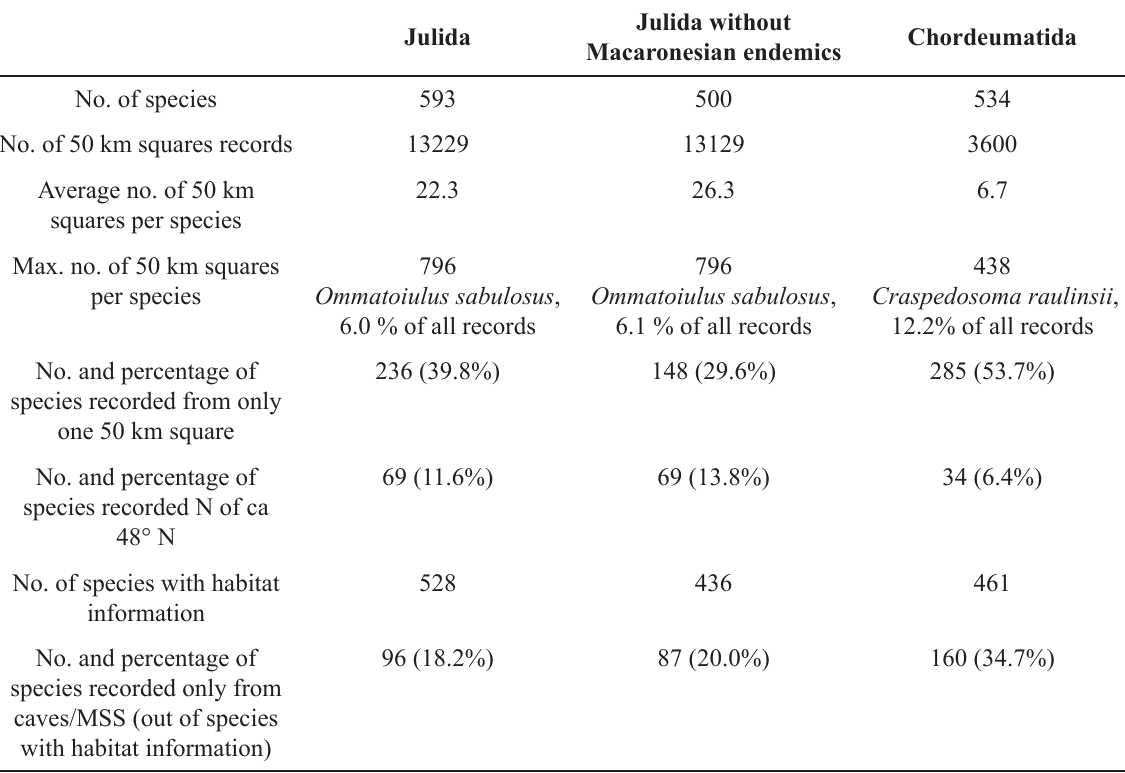
Table 4. A numerical comparison of Chordeumatida and Julida. Data on Julida from Kime & Enghoff (2017). Macaronesian endemics constitute a significant proportion (15%) of the julidan species. As there are no Macaronesian endemics in the Chordeumatida, the numbers for Julida without Macaronesian endemics are more comparable to those for Chordeumatida. See